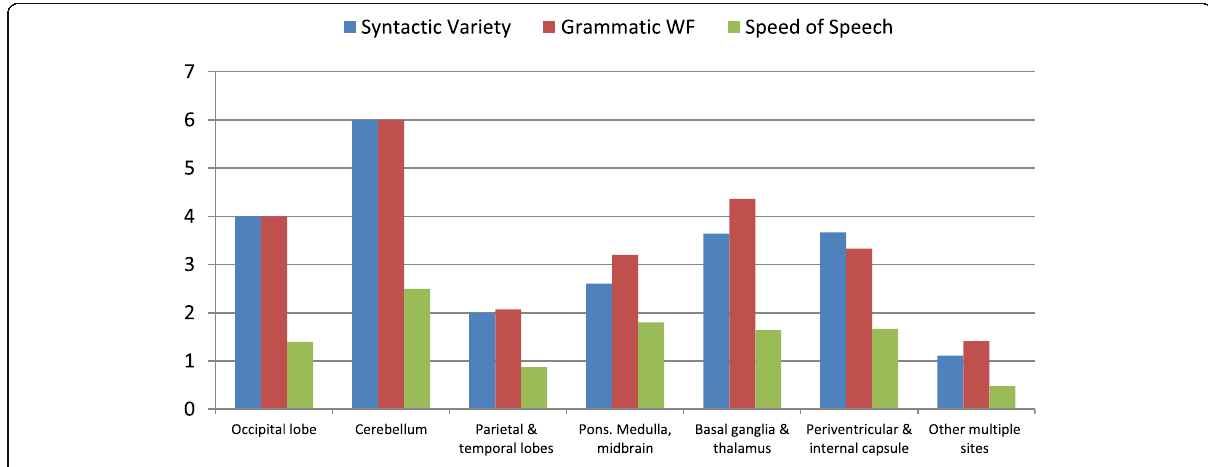
Fig. 10 Relation between lobar site and SPD-CAT